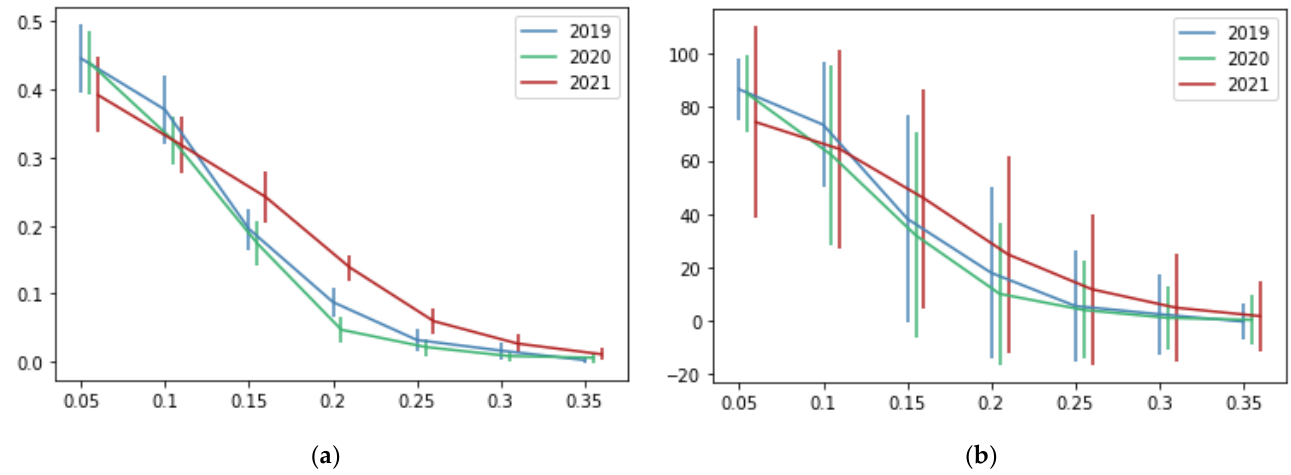
Figure 9. Results of matrix factorization according to the values of the parameters pmin ( x -axis). Vertical lines represent the standard deviation. ( a ) Percentage of correct recommendations ( y -axis) on a scale from 0 to 1. ( b ) The average number of recommended restaurants ( y -axis). Table 6. Results of matrix factorization according to the value of the parameter pmin .